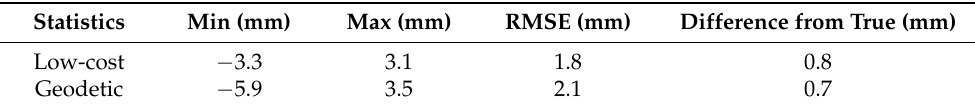
Table 8. The ellipsoid height statistics for low-cost instruments ( receiver : ZED–F9P; antenna : Survey Calibrated) and geodetic instruments ( receiver : Leica GS18; antenna : LEIGS18).